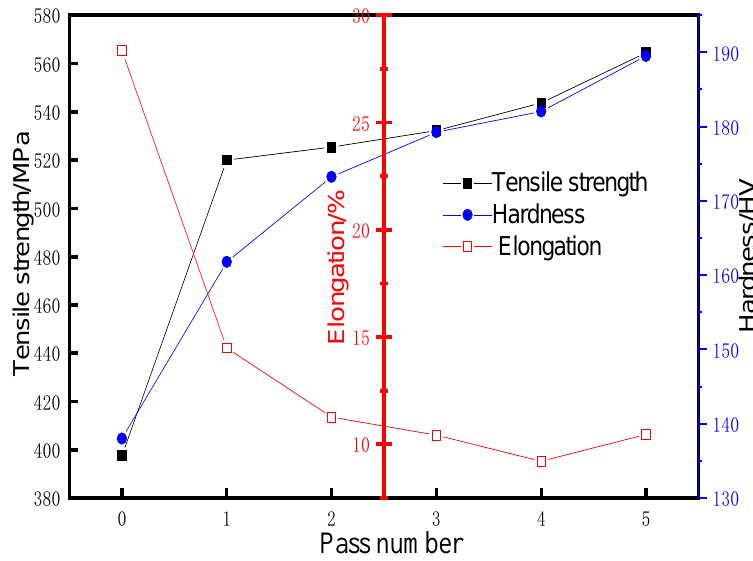
Figure 4. Mechanical properties of the Cu1.5Cr0.1Si alloy after C-path deformation.